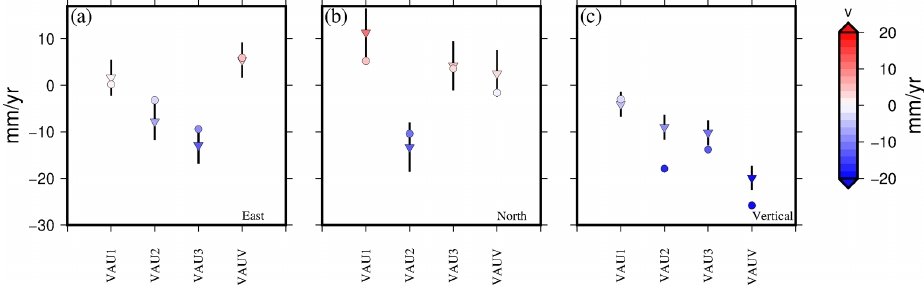
Figure 8. Three components of the velocity from GNSS and the Dual InSAR geometry–leveling combined dataset observed at GNSS locations (VAU1, VAU2, VAU3, VAUV; see Fig. 2). Inverted triangles represent the (a) east, (b) north, and (c) vertical components of the velocity from the combined dataset, the vertical bars indicate the associated uncertainties, and the circles stand for the GNSS